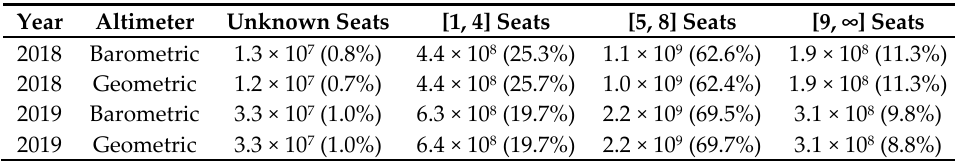
Table 6. Frequency of rotorcraft operating at or below 1200 feet